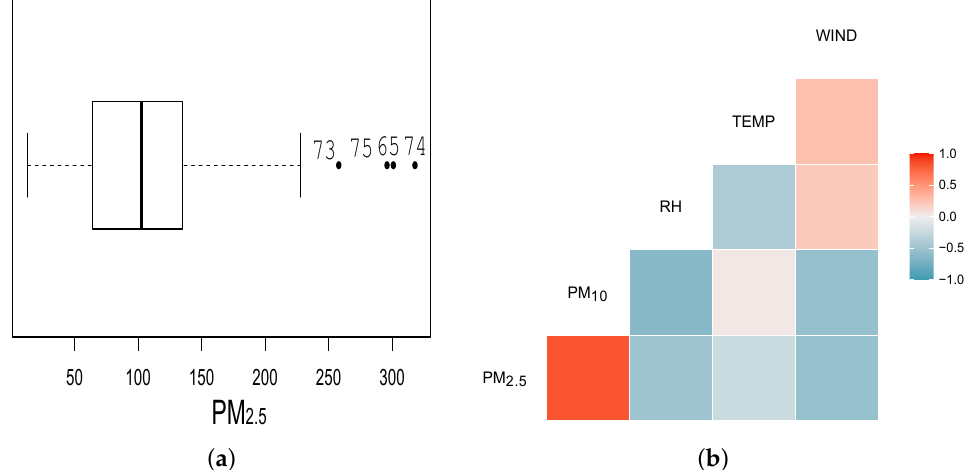
Figure 1. ( a ) Boxplot for PM 2.5 levels recorded by the Pudahuel monitoring station in Santiago, Chile, during 2015 and ( b ) scatter plot with the corresponding correlations for the indicated explanatory variables and response